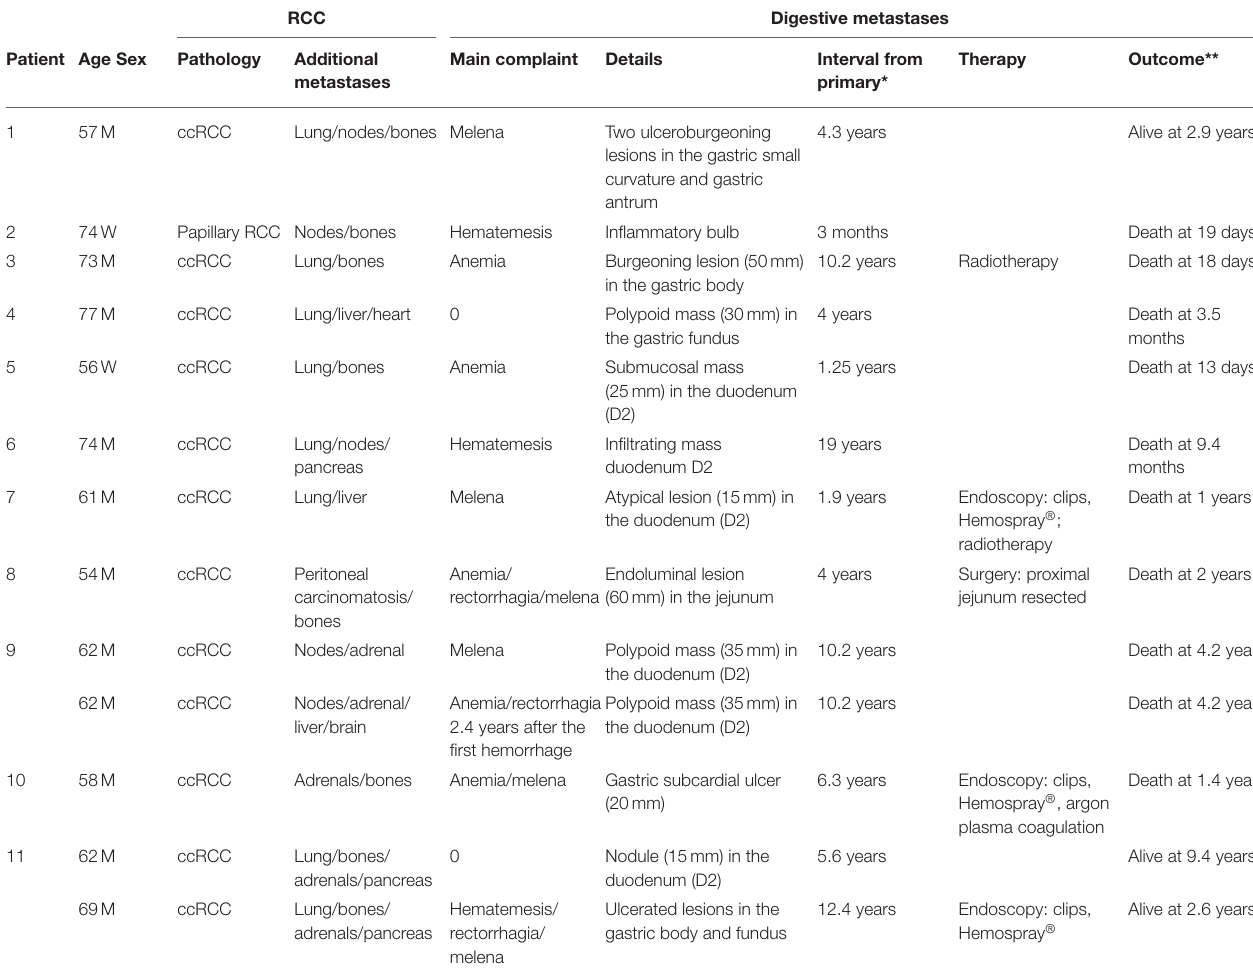
TABLE 1 | Population